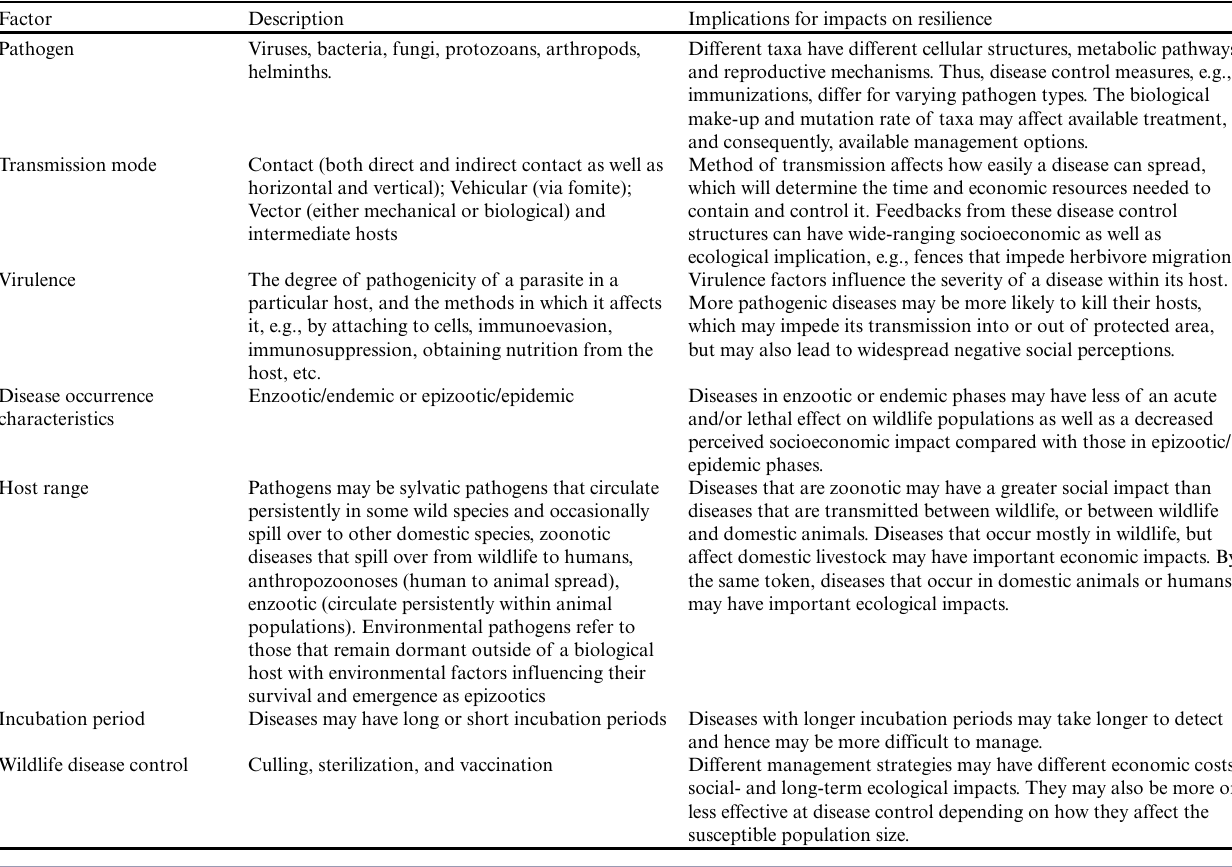
Table 2 . A typological table of factors of disease epidemiology and management that affect how diseases impact on protected area identity and resilience.